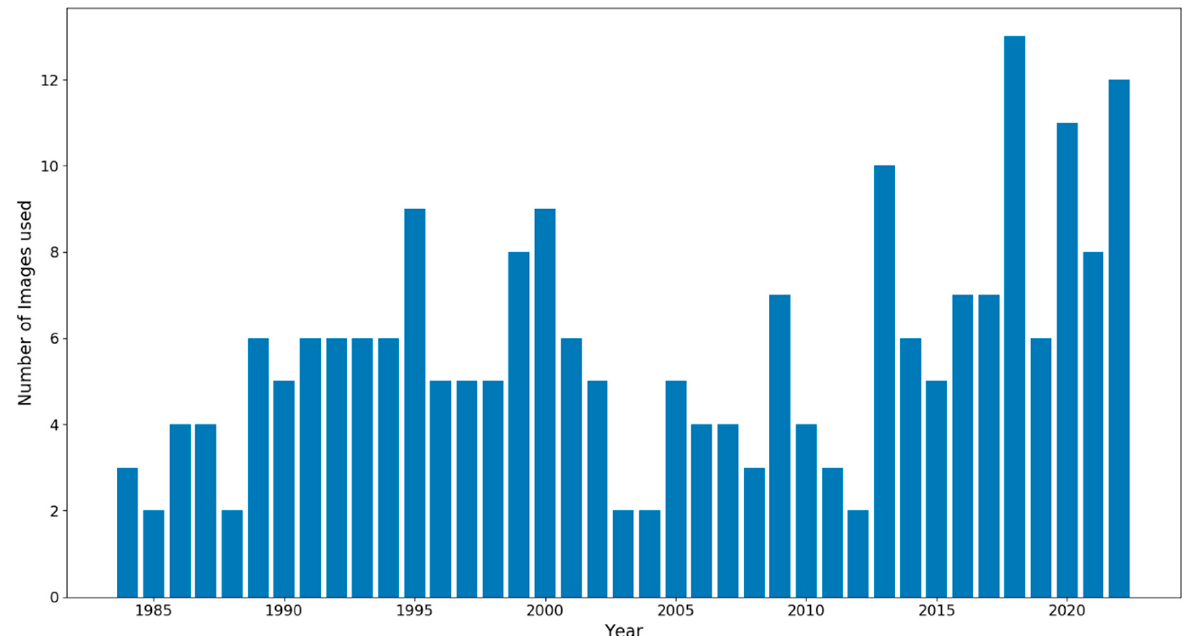
Figure 2. Number of Landsat images used to determine snow cover for each year in the study. times by as much as 20 km. Three such images were used from 1994, one from 1998 and one from 2009. These five images were correctly realigned using Ground Control Points (GCPs), locations whose latitude and longitude were known precisely. At least seven